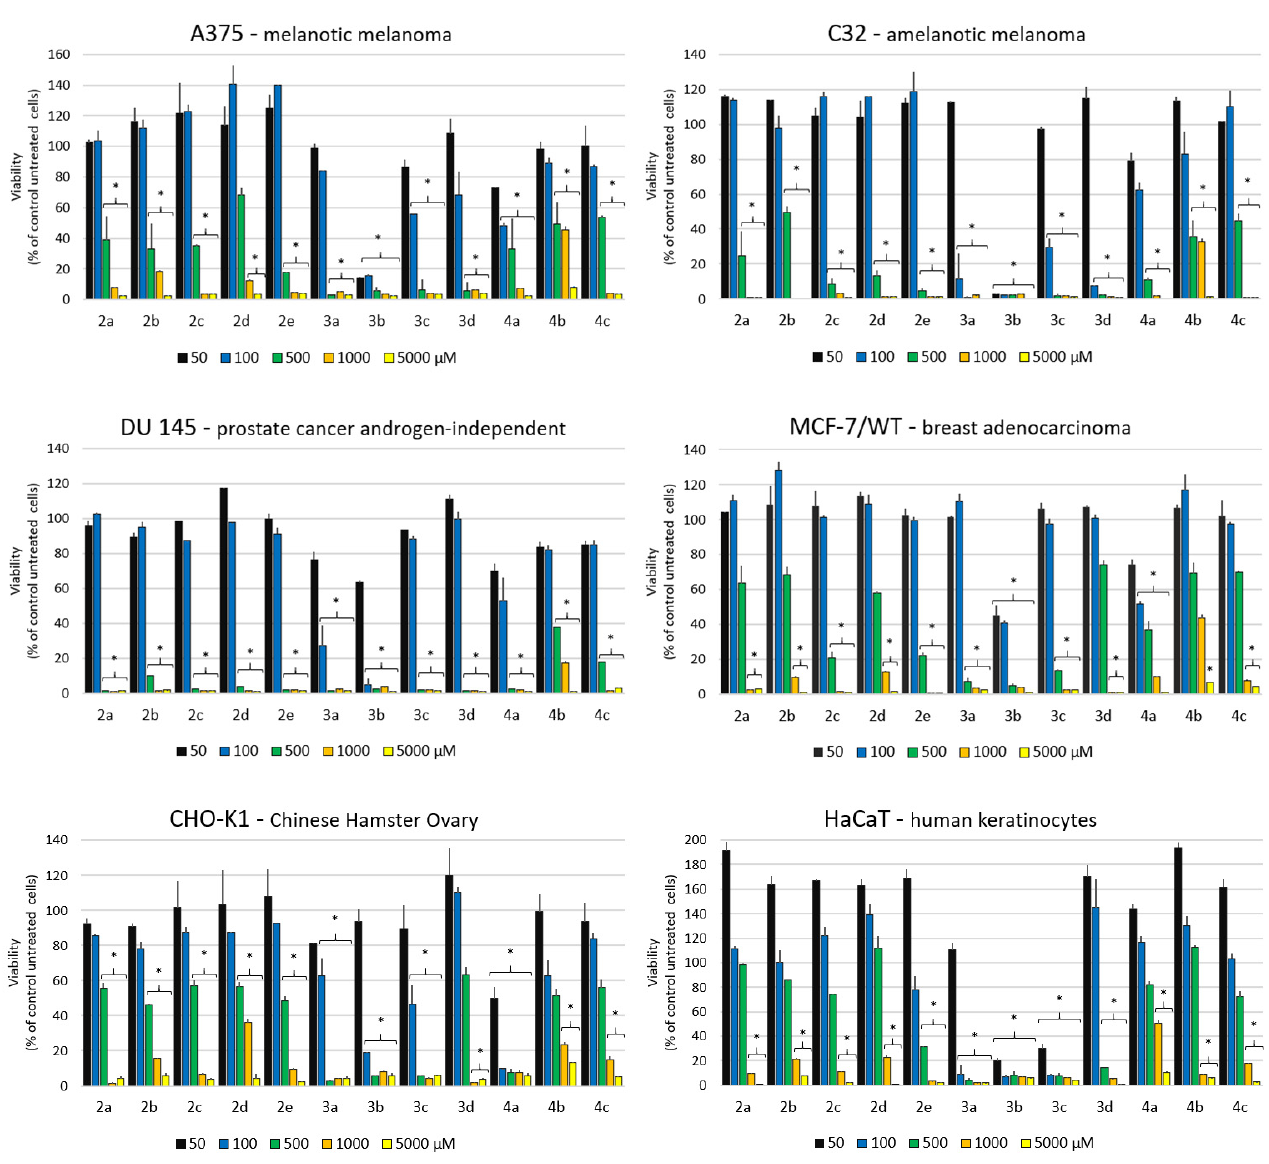
Figure 6. The viability of cancer and normal cells after 72 h exposition to compounds. The cell viability was determined by the MTT colorimetric assay. The compounds were tested in the 50–5000 µ M concentration range. The results are presented as percentage values ± SD from triplicate determinations, with p ≤ 0.05 (*) being considered statistically significant. Various DMSO concentrations were tested; viability results were at control level, data not shown in the graph.